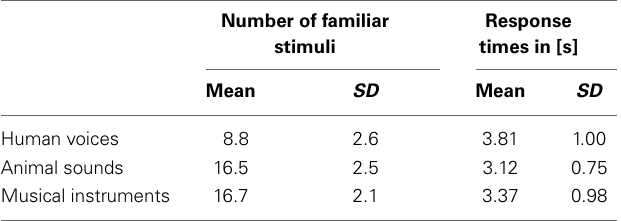
FIGURE 3 | Group activation maps of the temporal lobes at the FDR corrected significance level of q FDR < 0 . 05 for the contrasts (A) Human voices > Rest ( H + ) and (B) Human voices > Animal sounds + Musical